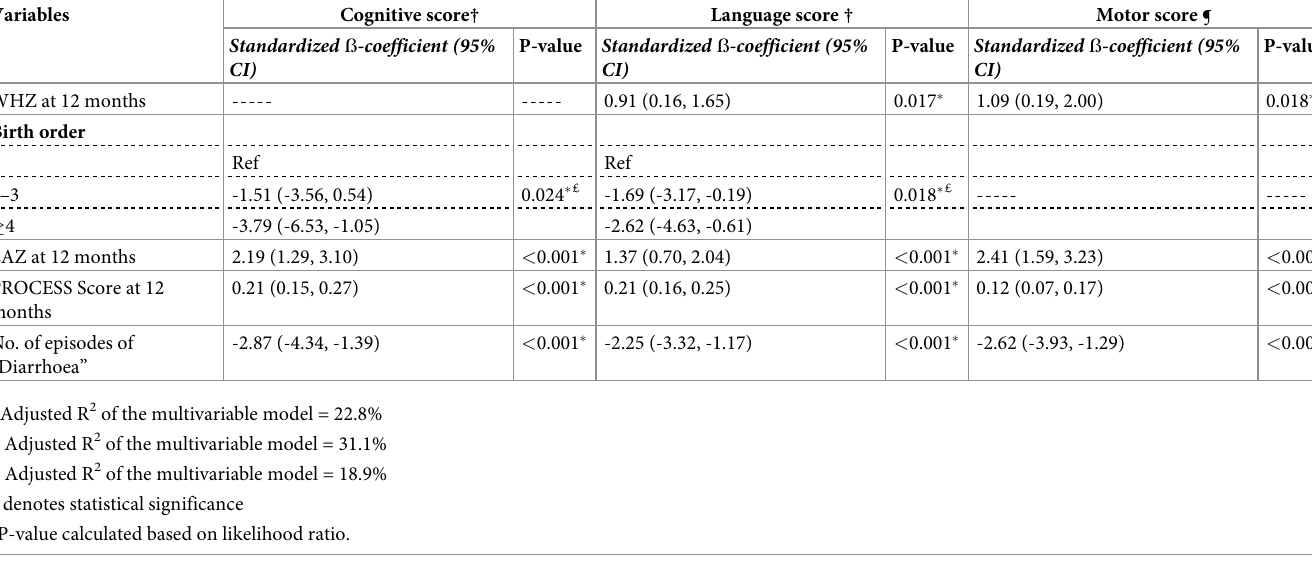
Table 2. Determinants of cognitive, language and motor scores, using multivariable linear regression, at 12 months of age in low birth weight infants from rural Haryana (N = 516).